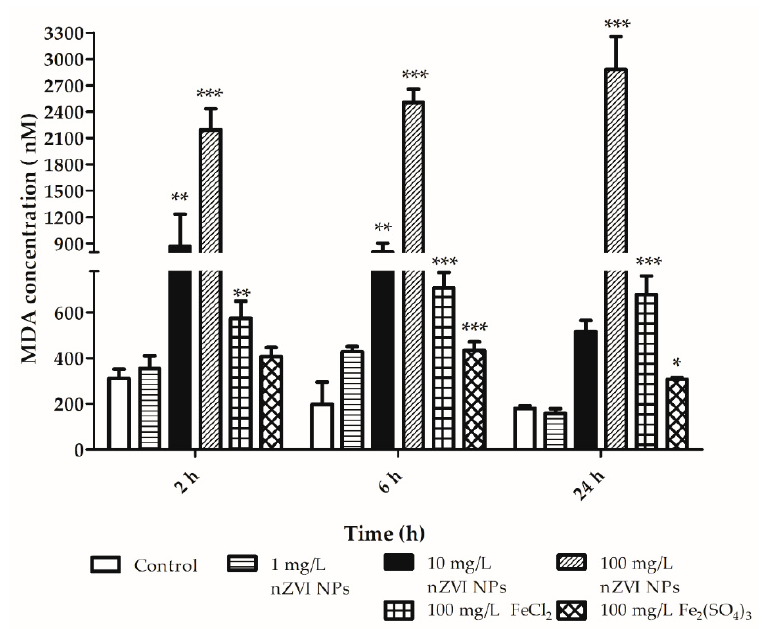
Figure 7. Malondialdehyde (MDA) formation in amoebocytes after exposure to nZVI NPs, FeCl 2 and Fe 2 (SO 4 ) 3 for 2, 6 and 24 h.